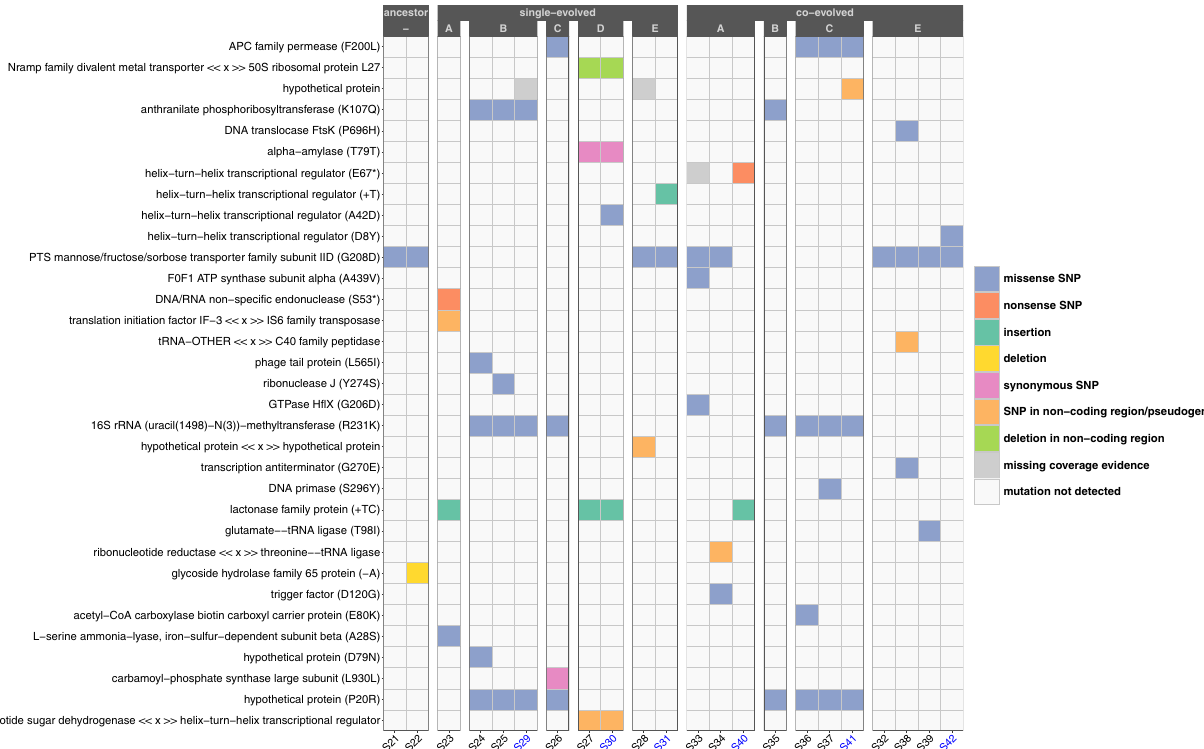
Fig. 4 Predicted mutations in ancestral and evolved Lactococcus lactis isolates reveal distinct genotypes emerging from mono- and co- cultures. A selection of L-(black-labels) and S-morphotype (blue-labels) isolates ( X -axis) evolved in mono-cultures or co-cultures, respectively, and two ancestors were selected for whole-genome sequencing. Predicted mutations by the computational pipeline breseq, including SNPs, insertions, and deletions in coding and non-coding regions, are arranged according to the isolates ’ evolutionary background (ancestor, mono- or co-culture) and experimental lineage (A – E). Y -axis with gene descriptions is listed according to the chromosomal position. Some of the unique mutations identi fi ed for co-cultivation are associated with growth, for example an ATP synthase or DNA translocase. In contrast, unique mutations of mono-culture variants are associated with for example an endonuclease. Noticeably, mutations in a helix – turn – helix transcriptional regulator were only identi fi ed in the S-morphotype, which suggests that this morphotype is associated with a change in this regulator. For more detailed information on chromosomal position and mutations, see Supplementary Table As a fi nal parameter, the acidi fi cation potential of the isolates It has been suggested that the inherent design of the bead- was assessed, due to its relevance in terms of dairy production. transfer-model selects for a fl exible “ life-history ” strategy, favoring Measurements of pH post 24 h of incubation did however not reveal a signi fi cant difference from the ancestor for neither mono- nor co-cultivation isolates (Fig. 3D). specialists are only successful under short terms 18 . To test how the To identify genomic differentiation, we sequenced 20 isolates, representing mono- and co-culture and the S- and L-morphotype from different lineages. Although we identi fi ed 31 unique of the isolates. Both evolved mono- and co-culture isolates were mutations classi fi ed as single nucleotide polymorphisms (SNPs), signi fi cantly better at forming bio fi lm compared to the ancestor insertions, and deletions of which 71% occurred in coding regions, ( P adj < 0.0001 for both culture variants, MELM; Fig. 3C). However, a we did not identify a speci fi c gene that had mutated in most co- signi fi cant difference was also found between the two culture culture isolates (Fig. 4). However, it is relevant to note that this types, as the co-culture isolates were signi fi cantly better at bio fi lm experiment was limited to approx. 100 generations (Supplemen- formation than the mono-culture isolates ( P adj = 0.002, MELM; tary Fig. 1) and with daily transfer representing a bottleneck. Supplementary Fig. S5C). In addition, a signi fi cant difference was Hence, most mutations are lost by genetic drift and advantageous also found between the two different colony morphotypes, mutations thus require more generations to constitute a explained by cells of the L-morphotype producing more bio fi lm signi fi cant fraction of the population 19 . We did however identify than the S-morphotype ( P adj < 0.0001, MELM; Supplementary Fig. 5C). This was surprising as we expected the darker colonies of the an intriguing pattern; variants emerging from co-cultivation S-morphotype on Congo red and Coomassie blue plates tended to have mutations in genes related to growth, such as (Supplementary Fig. 2A) to be associated with enhanced DNA translocase or ATP synthase. Conversely, no such genetic expression of polysaccharides or proteins, which are commonly modi fi cations were identi fi ed in variants emerging from mono- present in a bio fi lm matrix. It is however important to notice that cultures (Fig. 4 and Supplementary Table 2). Moreover, we the S-morphotype tended to sediment (Supplementary Figure 3), identi fi ed mutations in a gene encoding a protein associated and hence its presence in the microwell liquid phase and with a helix – turn – helix DNA-binding motifs in four of the six S- encounters with the pegs extruding from the lids might be morphotype isolates. Such proteins often coordinate transcription reduced compared to the ancestor and L-morphotype, which of genes according to environmental conditions and act as could lead to lower levels of bio fi lm formation in the PEG lid assay regulators 20 . The remaining two S-morphotypes either had a SNP used for bio fi lm quanti fi cation. (S41 Fig. 4) or a potential SNP (S29, Supplementary Table 2) in a